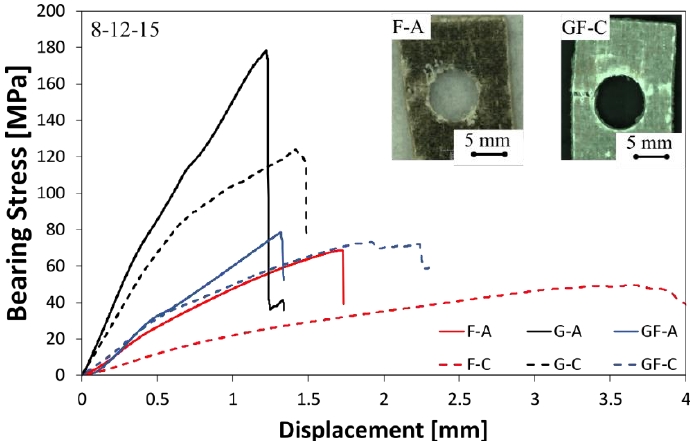
Figure 5. Typical stress – displacement curves of unaged (solid lines) and aged (dotted lines) pinned laminates with D = 8 mm and E = 12 mm.